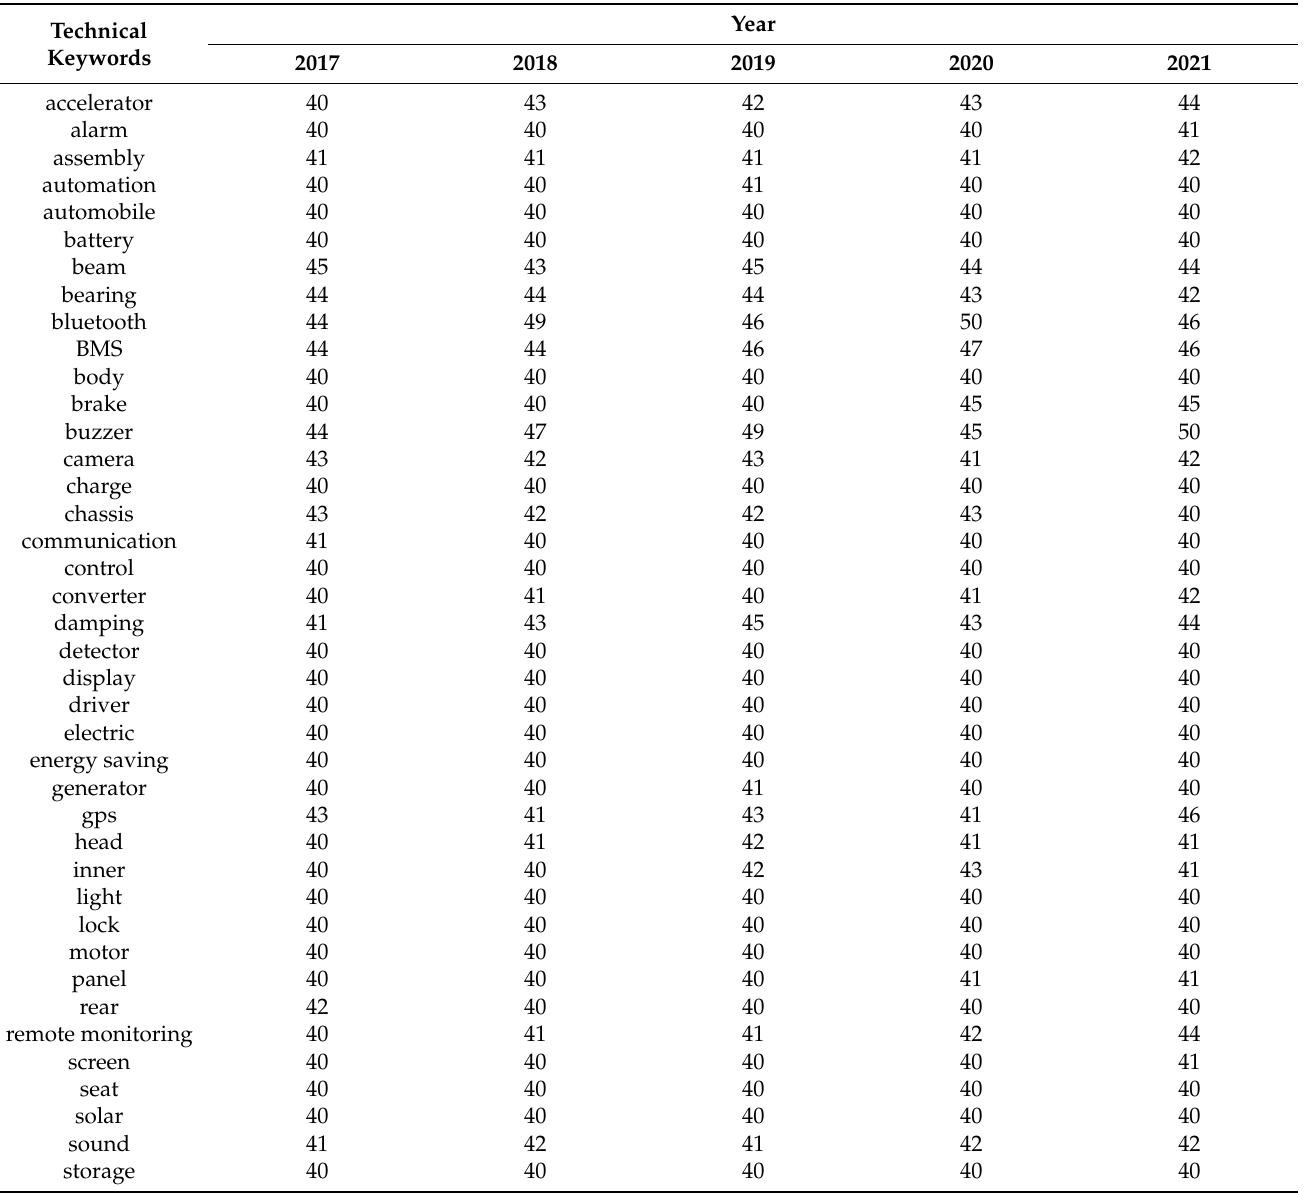
Table A4. Closeness centrality of technical keywords in